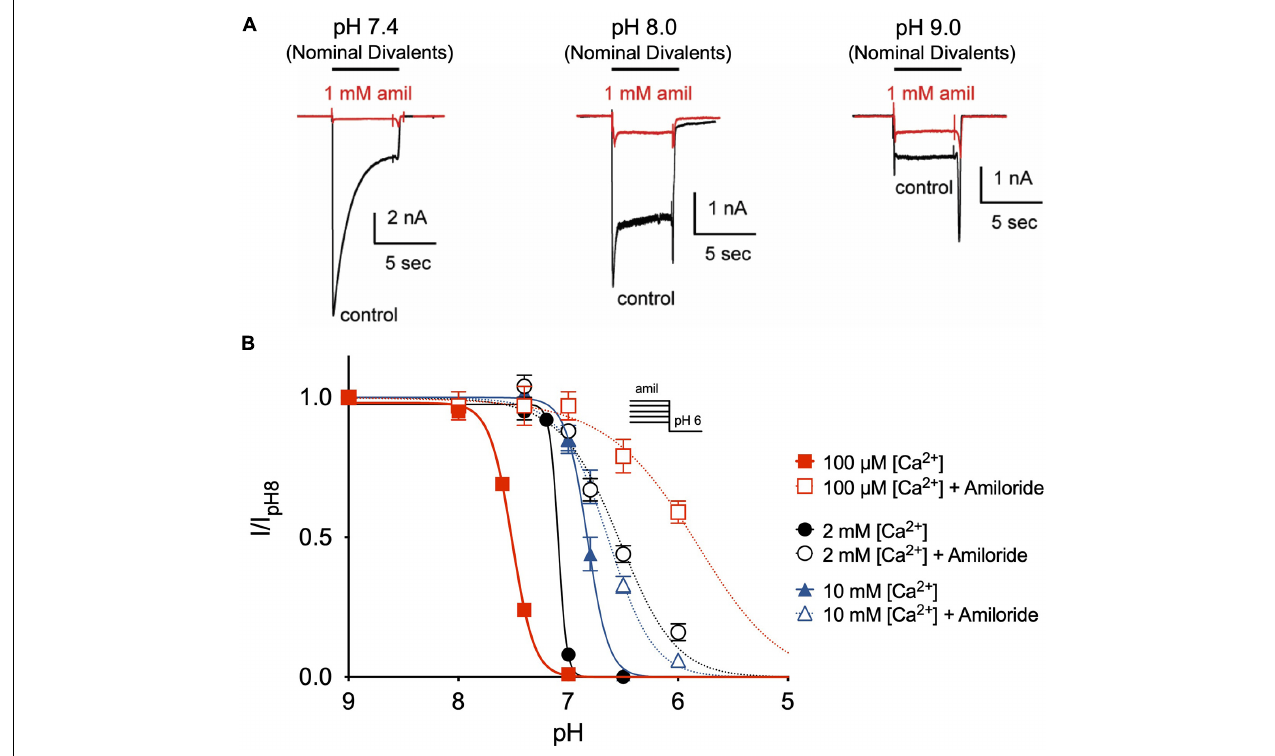
FIGURE 6 | Amiloride potentiation requires divalent cations. (A) Overlay of representative ASIC3 currents evoked by stepping from pH 8 (containing 2 mM Ca 2 + and 1 mM Mg 2 + and no amiloride) to solutions without added Ca 2 + and Mg 2 + (nominal divalents) at pH 7.4, 8.0, and 9.0 in the absence (control) or presence of 1 mM amiloride. (B) pH dose-response curves for steady-state desensitization (SSD) recorded in either 100 µ M, 2 mM, or 10 mM extracellular Ca 2 + (no added Mg 2 + ) in the desensitizing solutions in the absence of amiloride (pH 50 = 7.51, 7.09, and 6.82, respectively) and in the presence of 1 mM amiloride (pH 50 = 5.86, 6.57, and 6.64, respectively; n = 3–8 for each data